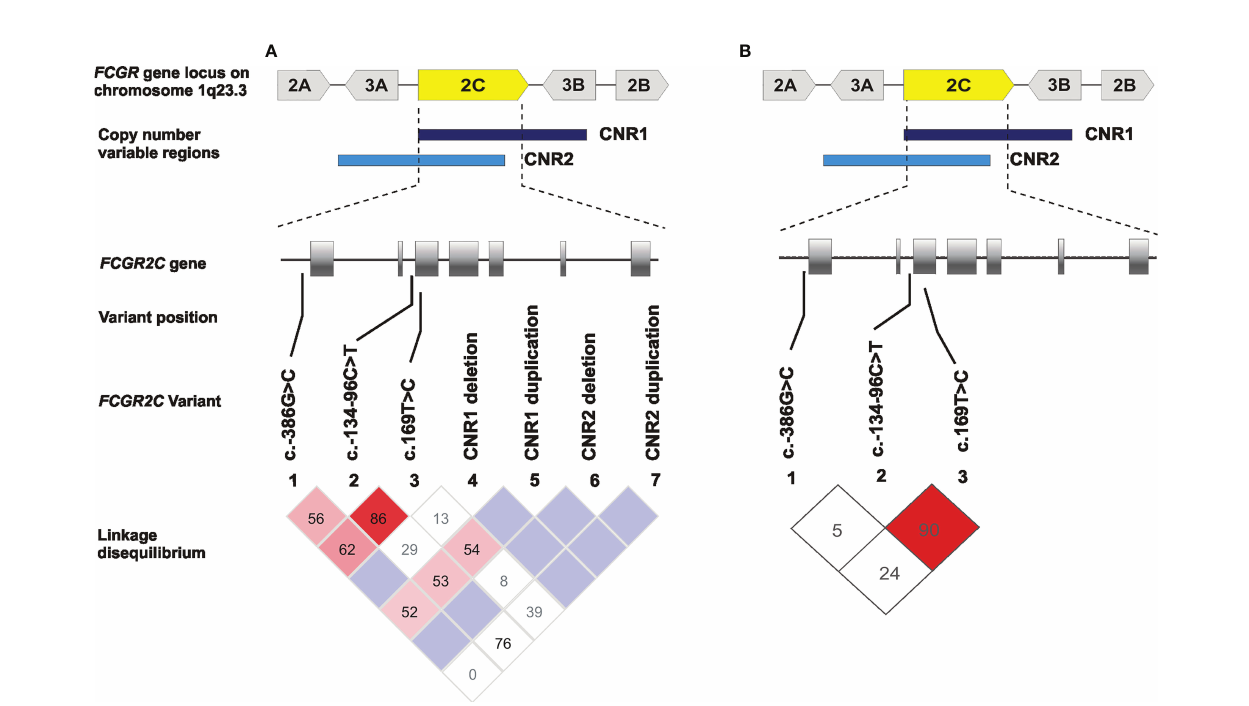
FIGURE 3 | Linkage disequilibrium of the single nucleotide polymorphisms (SNPs) and copy number regions (CNRs) in FCGR2C gene in South African children born to women living with HIV-1. (A) LD plots for SNPs without considering CNV and (B) when only those with two gene copies were included. Values re fl ect D ′ measures of LD and color in the squares given by standard D ′ /LOD (log of the odds of there being LD between two loci) color scheme, with bright red color used to display very strong